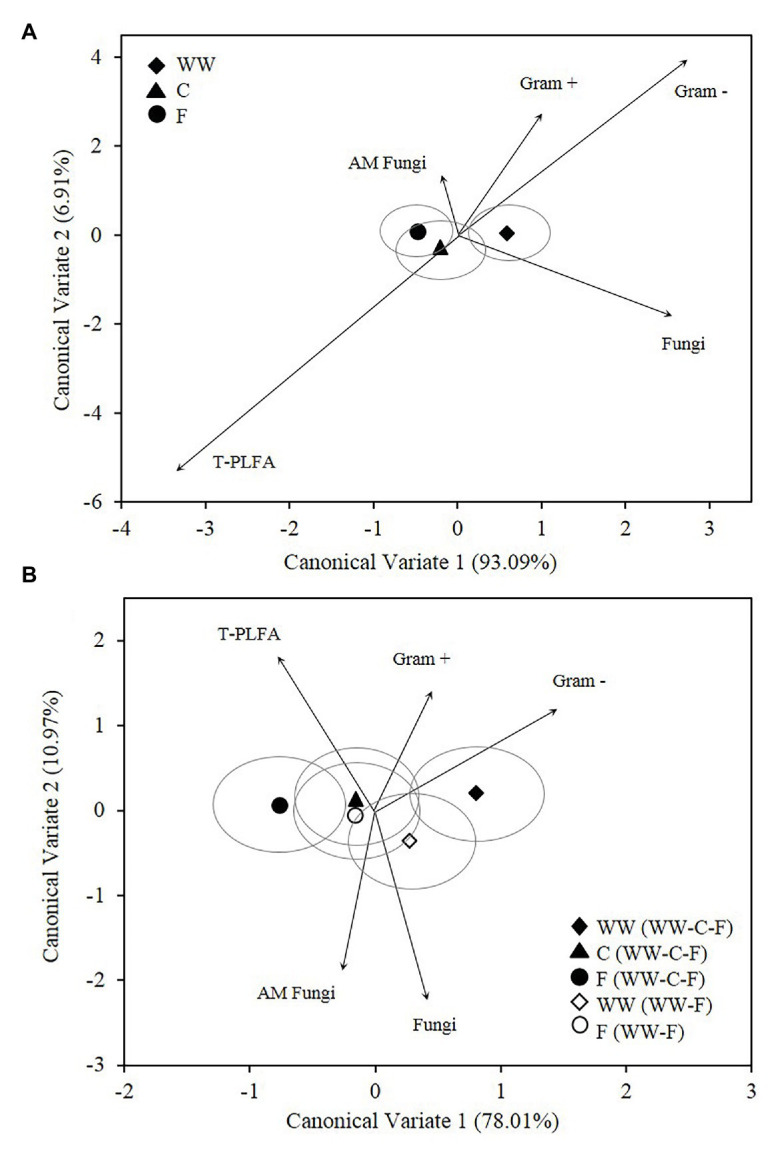
Canonical variates for lipid biomarker groups. Biomarker groups and total PLFA (T-PLFA) of soil from 2010 to 2012. Classification variables for the canonical analysis were crop/fallow (A) and crop/fallow phase of each rotation (B). Vectors represent standardized canonical coefficients and indicate the contribution of each biomarker group to each canonical variate. Each point represents the group mean and is accompanied by a mean ellipse at the 95% CI (treatments groups that differ significantly have confidence ellipses that do not intersect). WW, winter wheat; C, camelina; F, fallow.